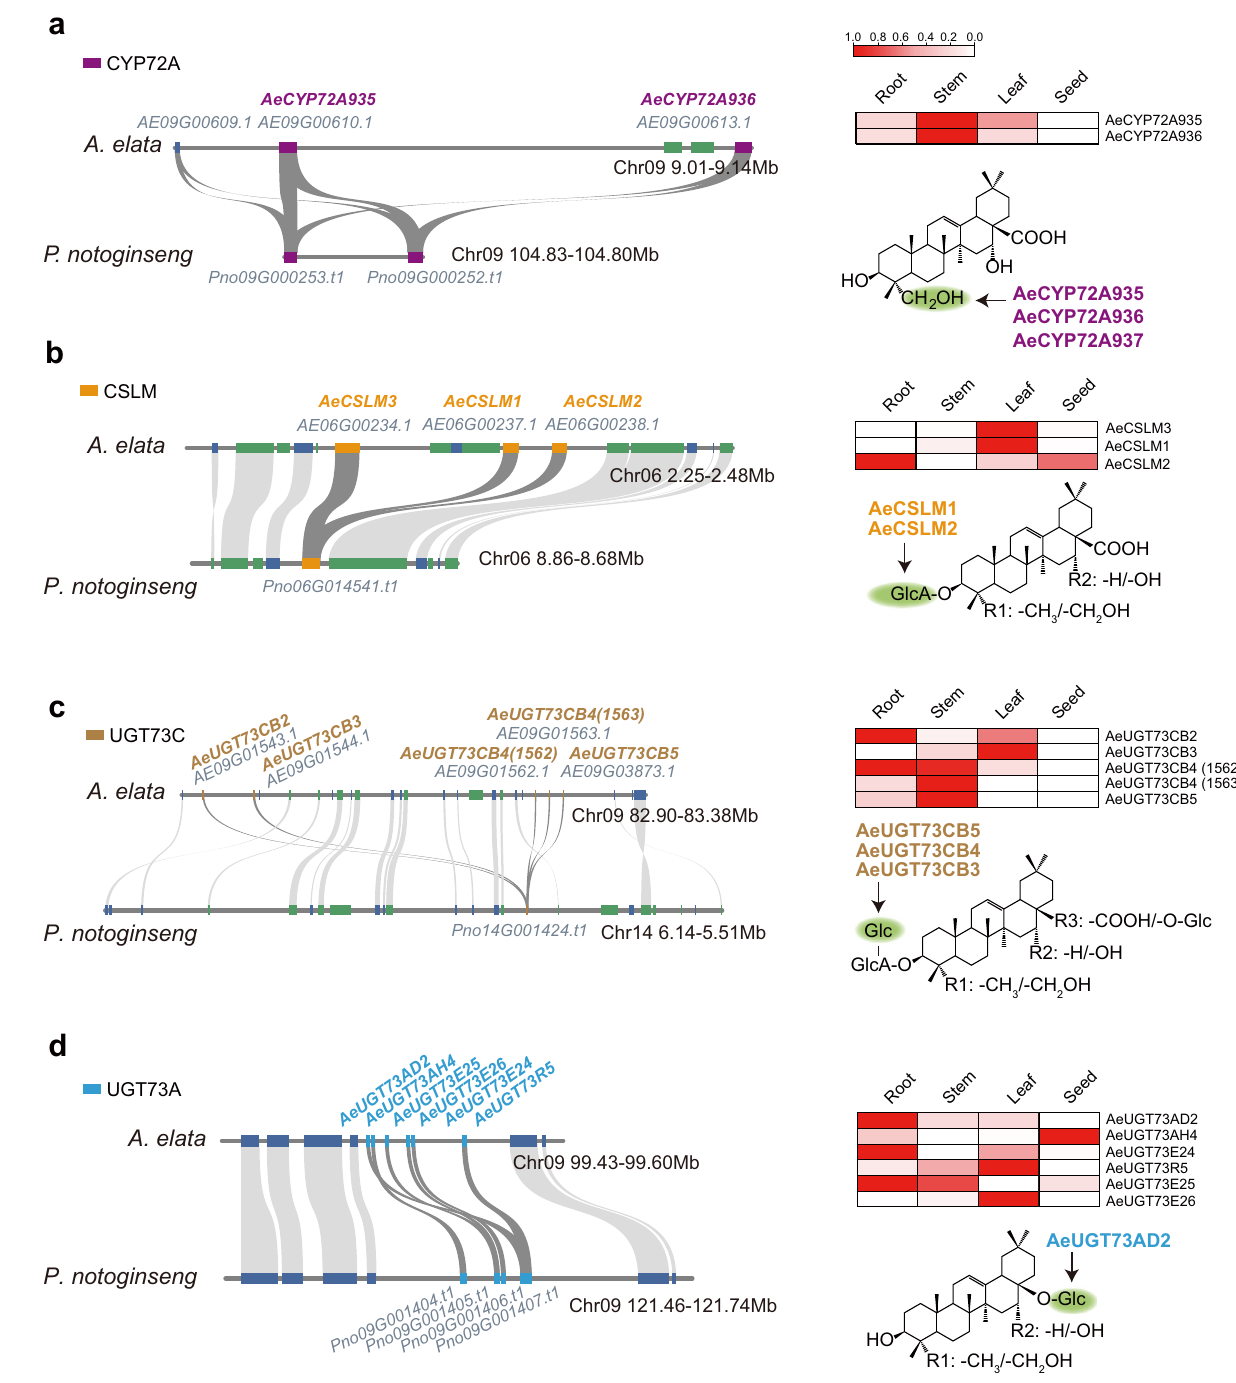
Fig. 5 Tandem duplication of genes drives the diversity of oleanane-type pentacyclic triterpenes in A. elata . The colinearity relationship of CYP72A ( a ), CSLM ( b ), and two UGT73 ( c and d ) tandem duplication regions between A. elata and P. notoginseng . The syntenic blocks are connected by gray lines. The heatmap shows the FPKM values (normalized) of the colinear gene in different tissues of A. elata . The green circles represent the tandem-repeat enzyme- modi fi cation positions. The blue bar represents the genes on the forward strand of the genome; the green bar represents genes on the reverse strand. Source data are provided as a Source Data fi